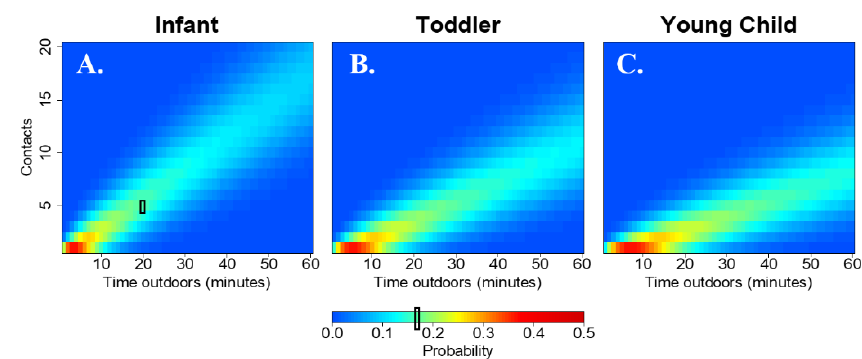
Figure 4. Temporal trends using the probability density of a Poisson distribution parameterized by the lambda of hand-to-mouth contacts for infants ( A ); toddlers ( B ); and young children ( C ). Each vertical slice represents the probability of observing a discrete number of contacts given that the child plays in a public area for a specific time-span. For example, the probability of an infant engaging in 5 hand-to-mouth contacts during 20 min of play at a public site is about 16% (black box in A ).